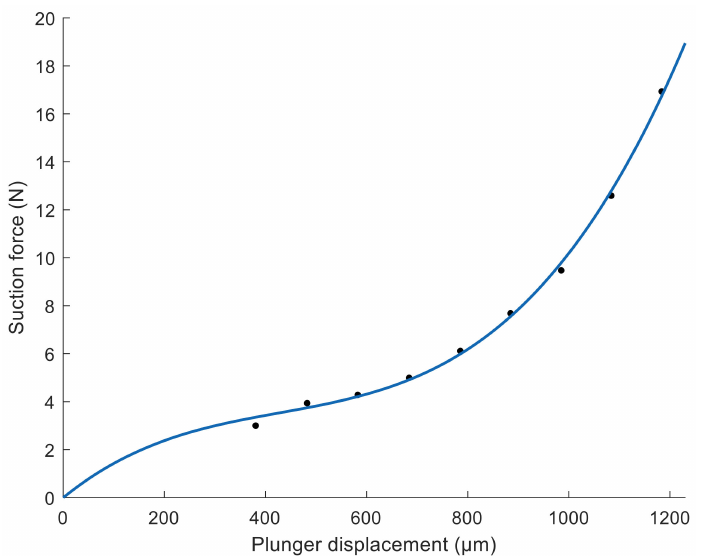
Figure 8. Experimental solenoid attraction force with varying air